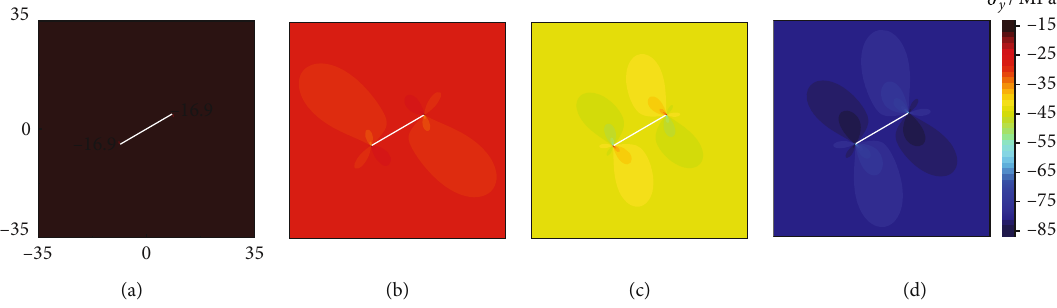
Figure 23: The contour plot of σ around the crack: (a) λ = 0 : 6 , Δ a / a = 0 : 33 ; (b) λ = 0 : 4 , Δ a / a = 0 : 50 ; (c) λ = 0 : 3 , Δ a / a = 0 : 67 ; and (d) λ = 0 : 2 y , Δ a / a = 1 .